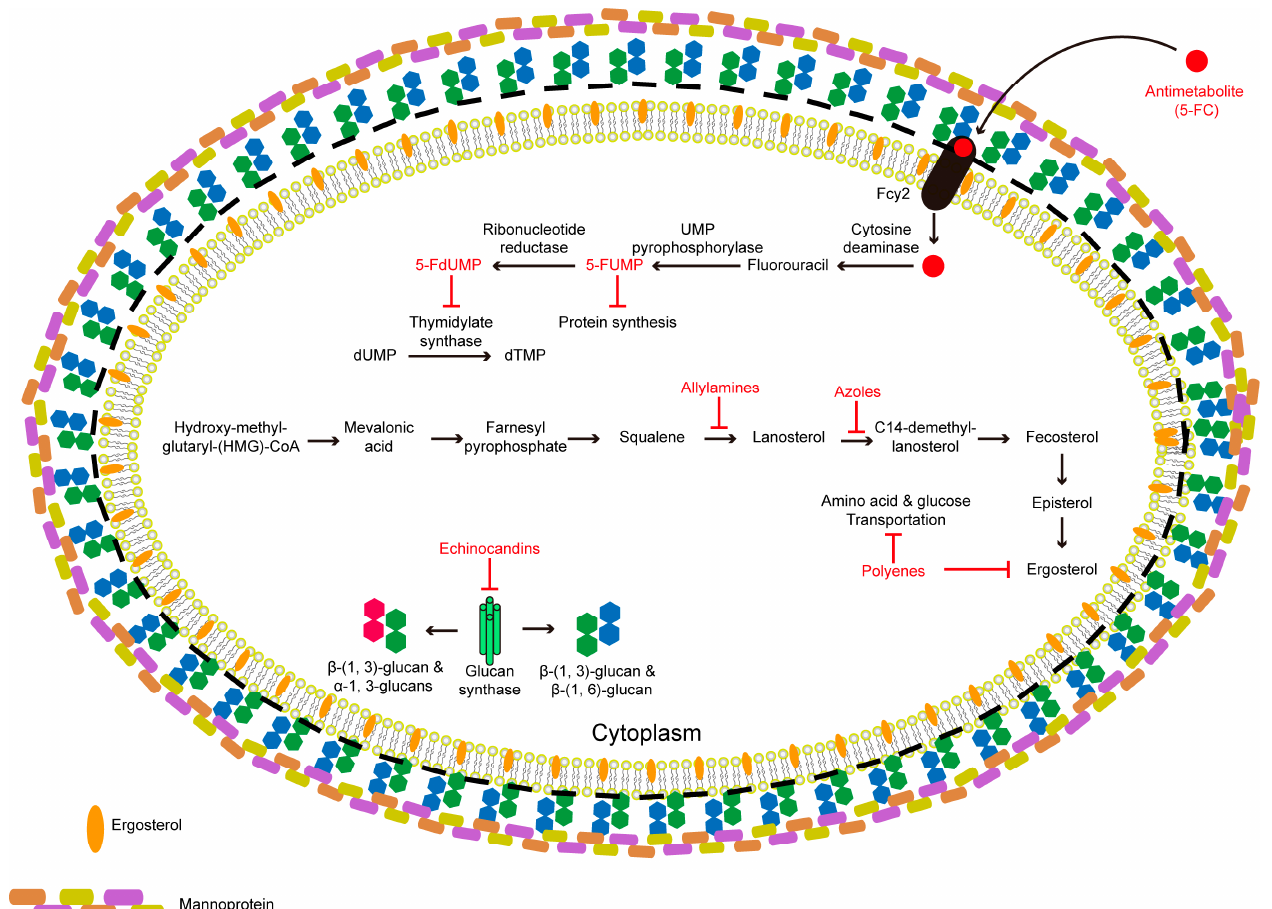
Figure 1. Schematic representation of the conventional antifungal agents, their targets, and actions. Antimetabolite, 5-Fluorocytosine (5-FC), is a fluorinated pyrimidine analog with fungicidal activity via interfering the pyrimidine metabolism, RNA/DNA and protein synthesis. First, 5-FC is taken up by fungal cells via a cytosine permease (encoded by gene FCY2 ) and is converted to 5-fluorouracil (5-FU), and is then transformed by UMP pyrophosphorylase into 5-fluorourdine monophosphate (5-FUMP). Then, 5-FUMP is incorporated into RNAs to inhibit the protein synthesis. Addi- tionally, ribonucleotide reductase enables the conversion of 5-FUMP into 5-fluorodeoxyuridine monophosphate (5-FdUMP), a potent inhibitor of thymidylate synthase that inhibits fungal DNA synthesis and nuclear division. Azoles are inhibitors for cytochrome P450-dependent enzyme lanosterol 14 α -demethylase (CYP51) encoded by the ERG11 gene, and thus block the conversion of lanosterol to ergosterol. Allylamines block ergosterol biosynthesis via inhibiting squalene epoxidase ( ERG1 ) that lead to squalene accumulation and increased permeability may cause the disruption of cellular organization. Echinocandins act as noncompetitive inhibitors of β -(1, 3)- D -glucan synthase enzyme complex and leads to disruption of the cell wall structure, resulting in osmotic instability and fungal cell death. Polyenes specifically bind to the lipid bilayer and form a complex with the ergosterol producing pores that leads to the disruption of the cell membrane, leakage of the cytoplasmic, contents and oxidative damage in fungal cells. Amphotericin B (AmB) binds ergosterol and forms an extra-membranous fungicidal sterol sponge destabilizing membrane